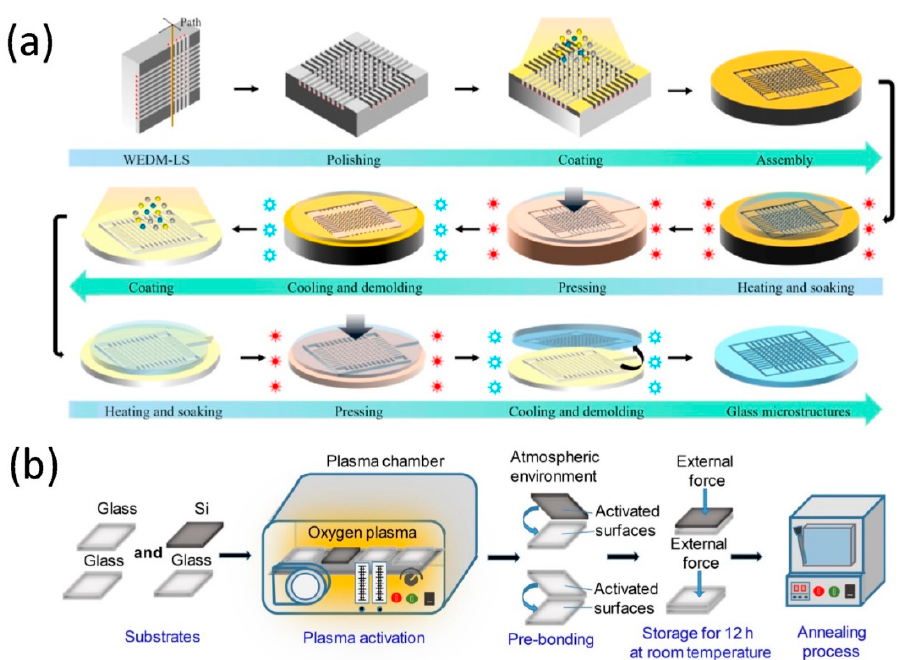
Figure 4. ( a ) Schematic diagram of the insert manufacturing process for tungsten carbide mold and high transition temperature glass mold; Reproduced from [74] with the permission from Elsevier Ltd. ( b ) Schematic diagram of oxygen-based plasma activation and low-temperature annealing process. Reproduced from [78] with the permission from Chinese Society of Metals.